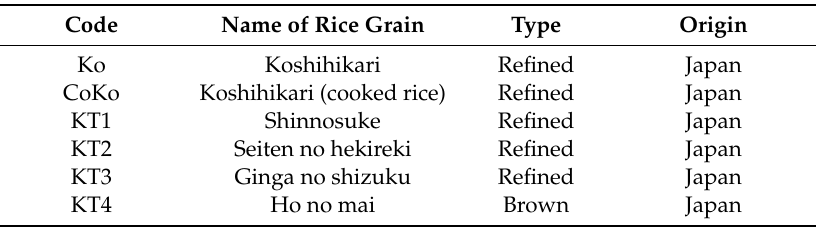
Table 1. Information of rice